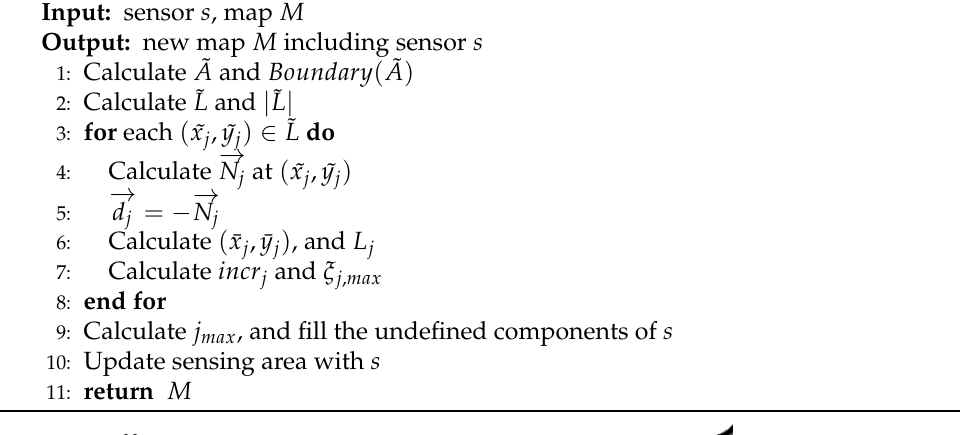
Algorithm 4: The proposed algorithm for deployment of an additional sensor.